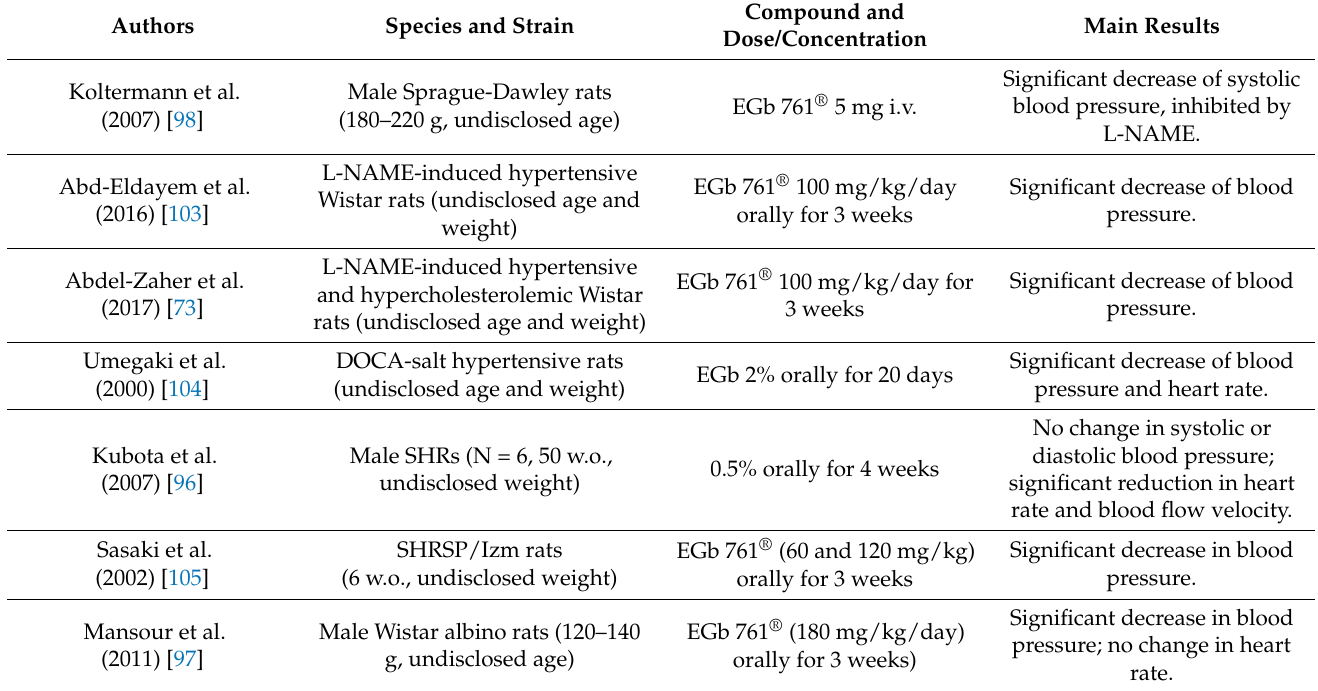
Table 3. Results of the anti-hypertensive activity of Ginkgo biloba in vivo (DOCA— deoxycorticosterone acetate; EGb—extract of Ginkgo biloba; i.v.—intravenous; L-NAME—N ω - nitro-L-arginine methyl ester; SHRs—spontaneously hypertensive rats; SHRSP/Izm—SHRs— spontaneously hypertensive stroke-prone rats; WKYRs—Wistar-Kyoto